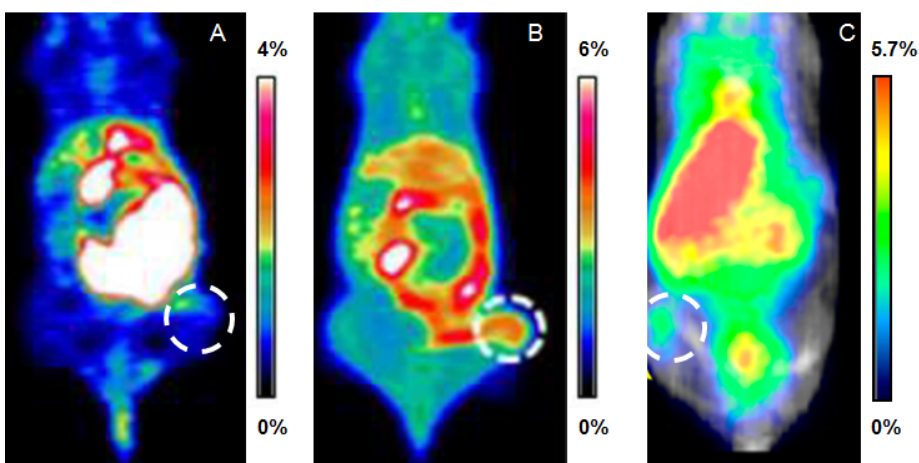
Figure 7 . In vivo PET images at 65 min of [ 18 F]FEE-PCur ( A ) and [ 18 F]FEEM-PCur ( B ) in C6 glioma- bearing mice, and at 60 min of [ 68 Ga]Ga-DOTA-C21 in a HT29 colorectal tumour-bearing mouse ( C ). Figure has been obtained by merging and elaborating images from references [50,51]. Reprinted with permission from [50,51]. Copyright 2011 RSC